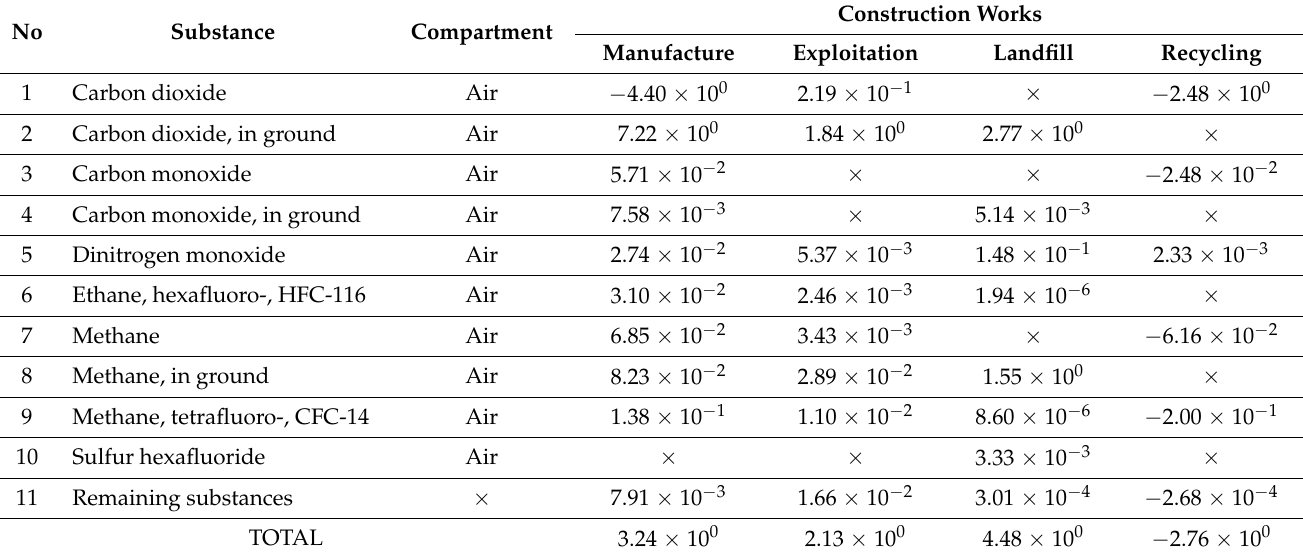
Table 8. The results of grouping and weighing the environmental consequences of emissions of compounds causing global warming due to construction works occurring at individual stages of the life cycle of the research object.